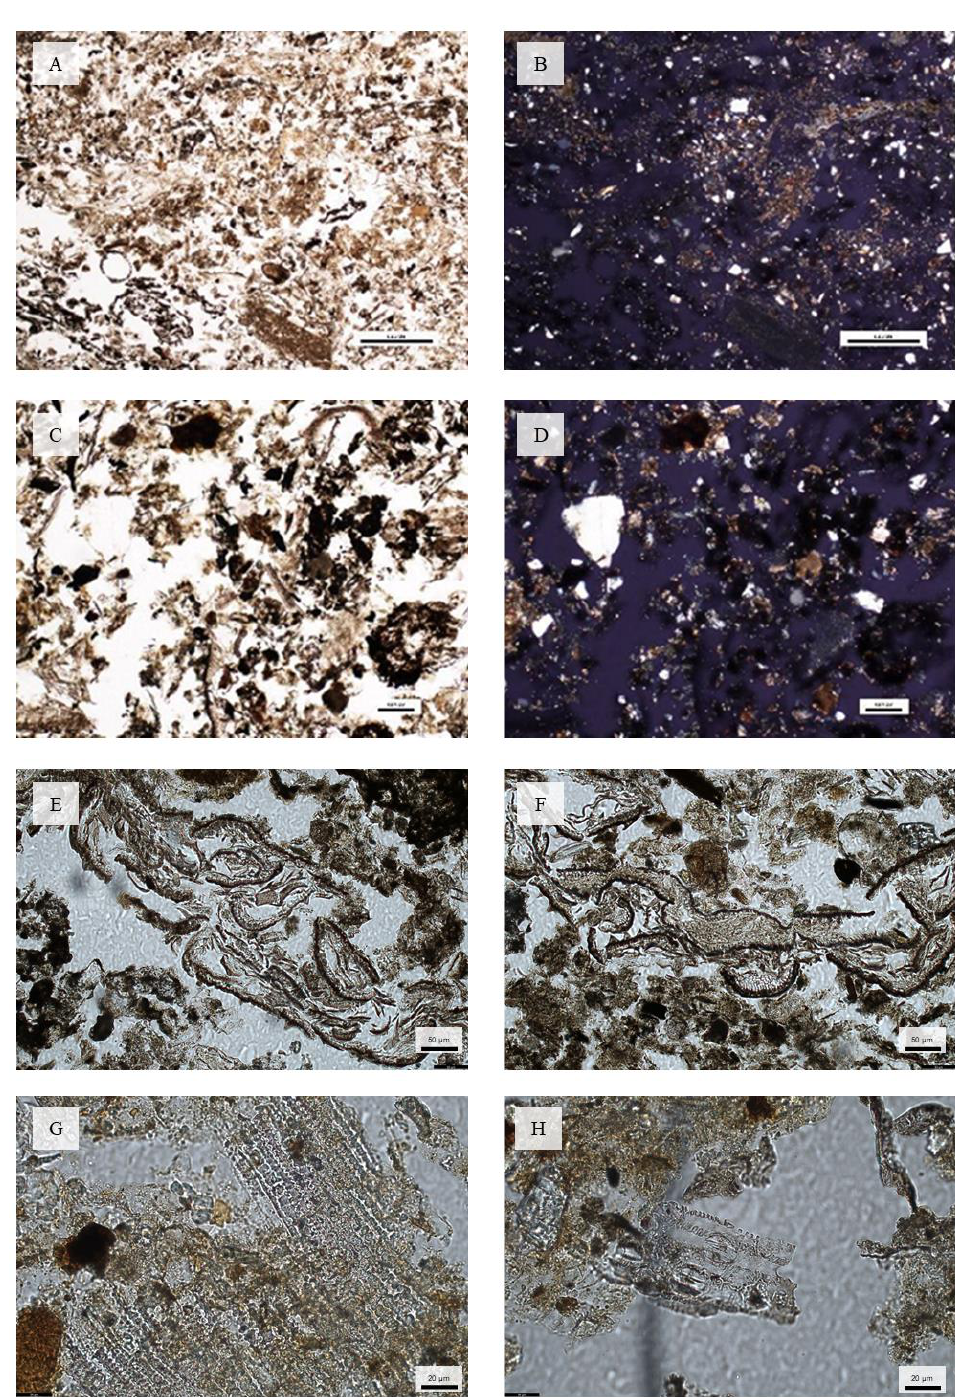
Figure 9. Microphotographs of MS43/1 2004: ( A , B ) matrix of the ashy layer (scale: 0.05 cm; PPL, XPL). ( C , D ) The same layer at higher magnification (scale: 0.01 cm; PPL, XPL). ( E , F ) Indication of vegetative organs of Gramineae with partly exposed silica content and charred organic matter (PPL, 50×), ( G ) Partly exposed elongated dendritic tissue element indicating the presence of cereal chaff material (PPL, 400×). ( H ) Stomata and epidermal cells of Gramineae as indication of grass vegetative organs (PPL, 400×).